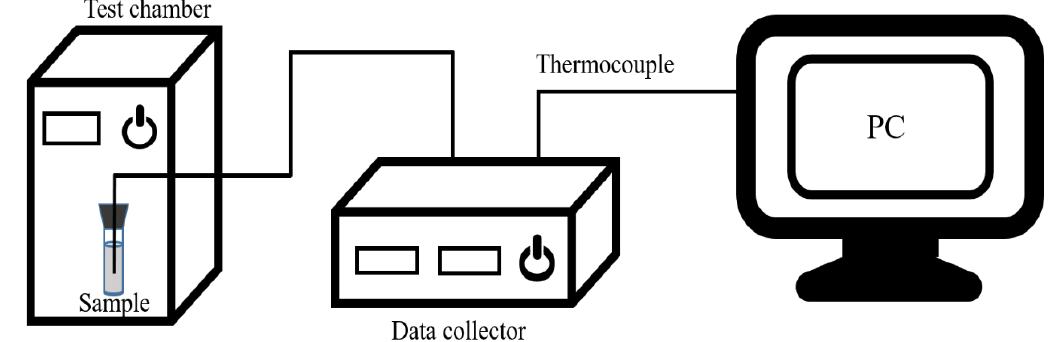
Figure 1. Schematic diagram of the experimental device for supercooling degree test.